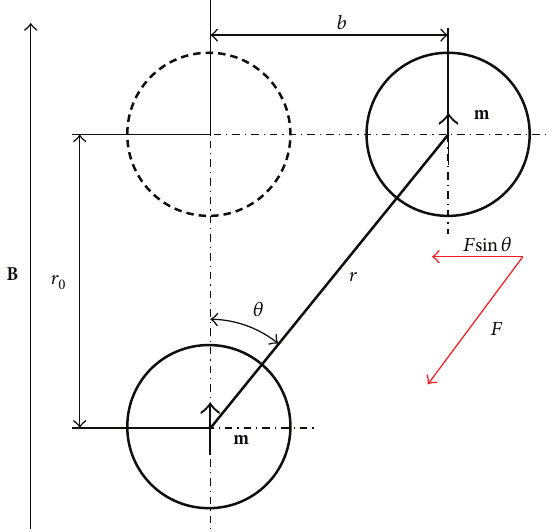
Figure 6: Dipole interaction in a straight